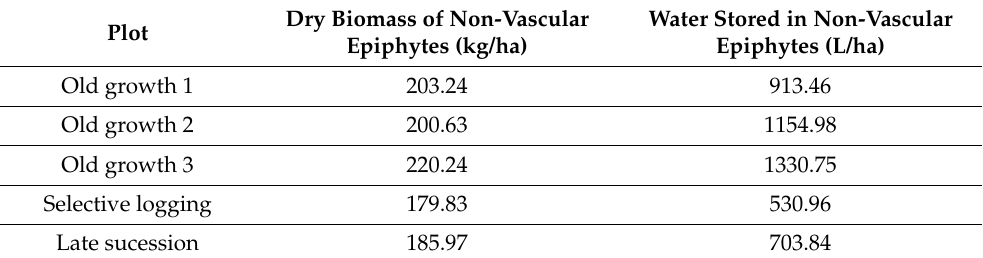
Table 1. Values of dry biomass of non-vascular epiphytes (kg/ha) and of water stored in these epiphytes (L/ha), in each of the permanent plots studied.